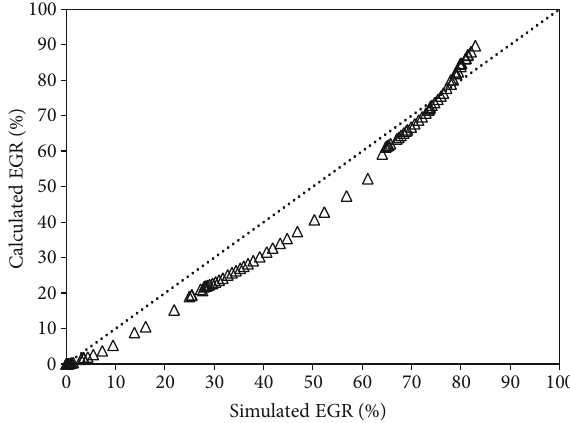
Figure 6: Comparison of calculated EGR against the simulated values, LPG : NG > 50 % . The dashed lines indicate relative errors equal to zero.